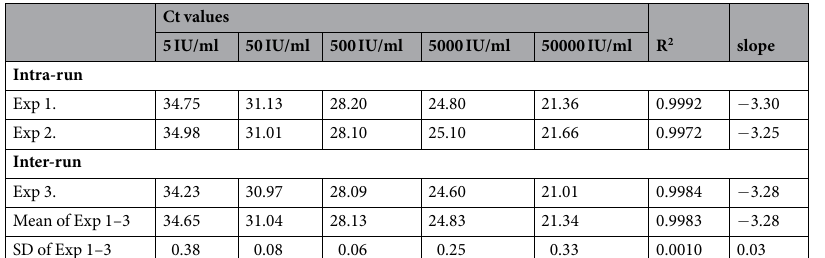
Table 2. Linearity of HDV molecular assay on WHO HDV dilutions. Shown are three experiments of 10-fold dilution series of WHO HDV plasma standard (5–50000 IU/ml) tested in the Abbott molecular prototype assay. Correlation coefficient (R 2 ) showing the linearity of each standard curve and slope denoting the amplification efficiency are given for each set of the serial dilutions.